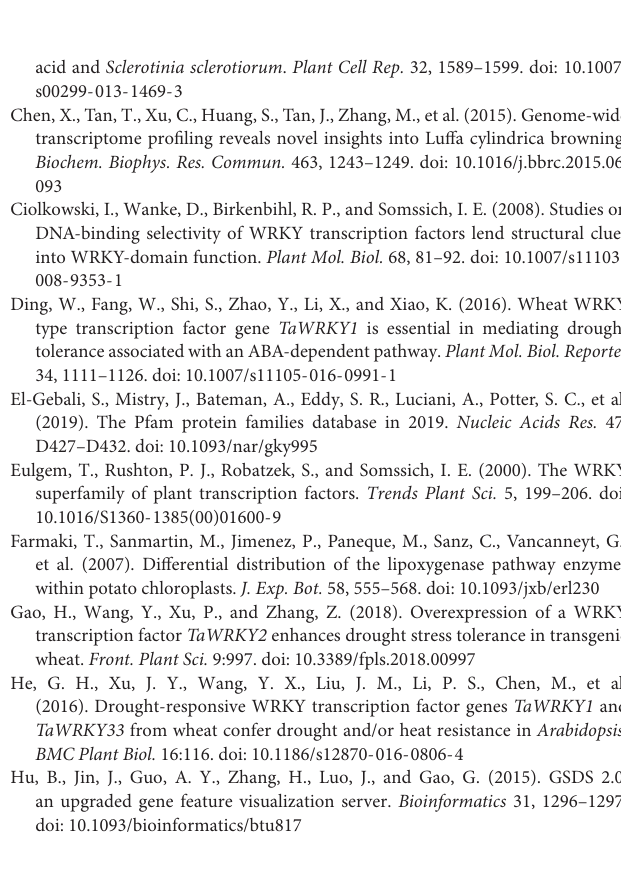
Bars show means ± SD. This experiment is replicated five times. (C) Observations of primary root elongations of WT and OE lines at 7 days after germination. Scale bars: 1 cm. (D) Statistics of primary root elongations of WT and OE lines at 7 days after germination. One-way ANOVA, followed by Tukey HSD test, was performed. There are no significant differences between WT and each OE line. Bars show means ± SD, n = 20. This experiment is replicated five times. Supplementary Figure 8 | Gene Ontology (GO) and Kyoto Encyclopedia of Genes and Genomes (KEGG) analyses of differentially expressed genes (DEGs) isolated from polyethylene glycol (PEG) and salt stress, respectively. (A) GO term analysis of DEGs identified from PEG treatment. (B) KEGG enrichment of DEGs identified from PEG treatment. (C) GO term analysis of DEGs identified from salt treatment. (D) KEGG enrichment of DEGs identified from salt treatment. Supplementary Figure 9 | Gene Ontology term analysis of seven common differentially expressed genes isolated from polyethylene glycol and salt treatments. Supplementary Table 1 | The primers used in this study. Supplementary Table 2 | The p -value of each TaWRKY gene based on the results of hmmsearch. Supplementary Table 3 | Information of all TaWRKY genes that were isolated in this